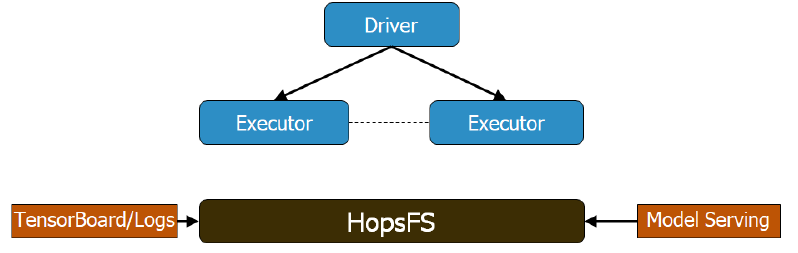
Figure 9. Distributed file